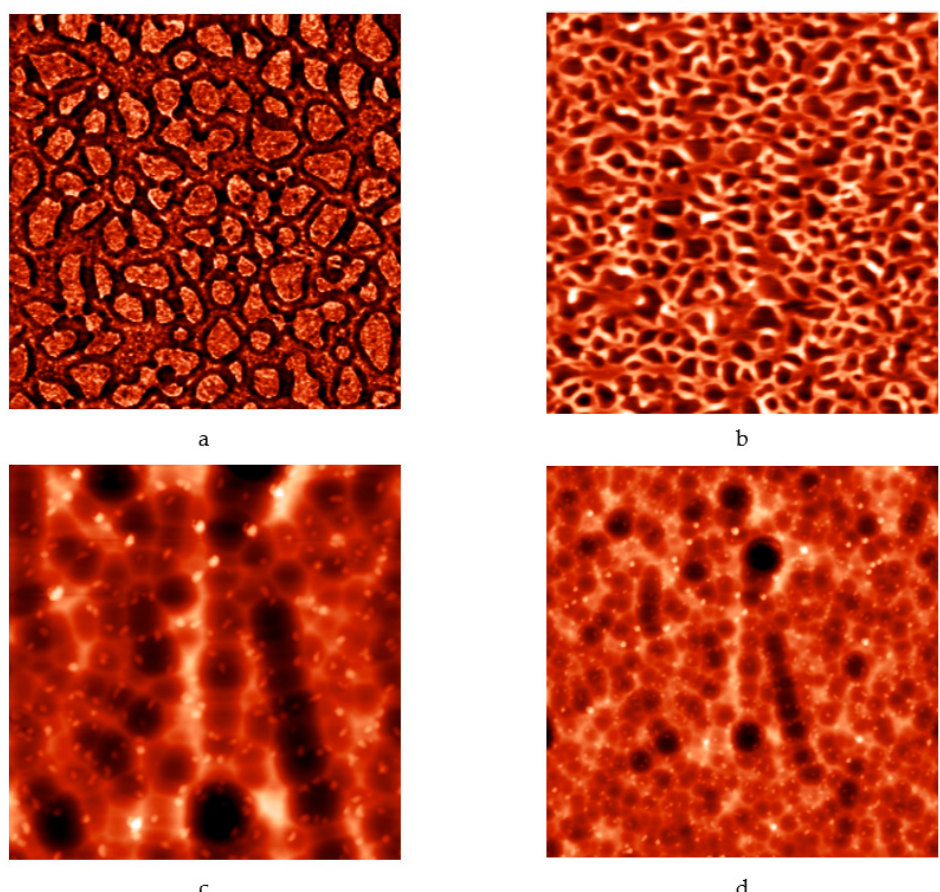
Figure 16. Atomic-force microscopy images of porous structures based on tin dioxide and silicon: ( a ) before etching in hydrofluoric acid (image size 5 μ m × 5 μ m); ( b ) before etching in hydrofluoric acid (image size 8 μ m × 8 μ m); ( с ) after etching (image size 20 μ m × 20 μ m); ( d ) after etching (image size 40 μ m × 40 μ m).